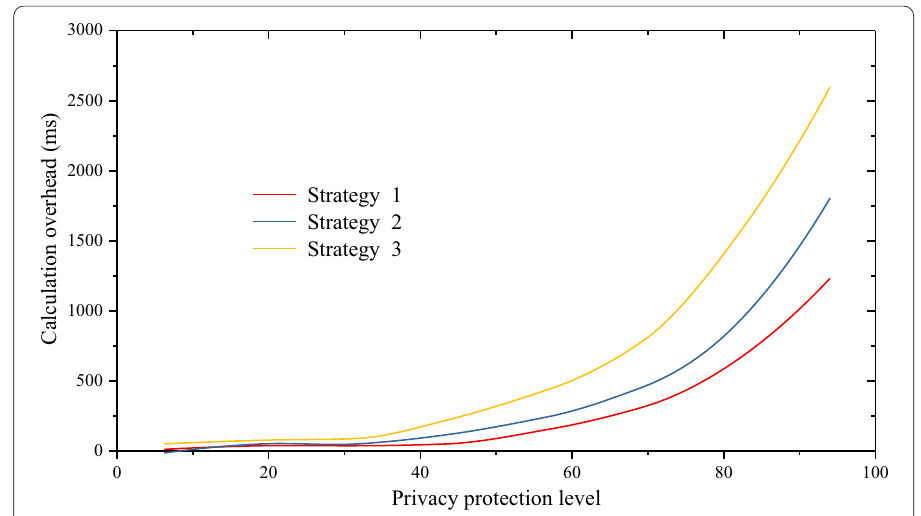
Fig. 6 The privacy protection level of the blockchain and the impact of computational overhead-initialization phase